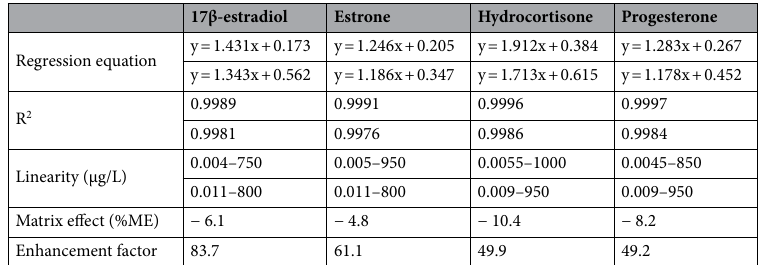
17β-estradiol Estrone Hydrocortisone Progesterone Regression equation